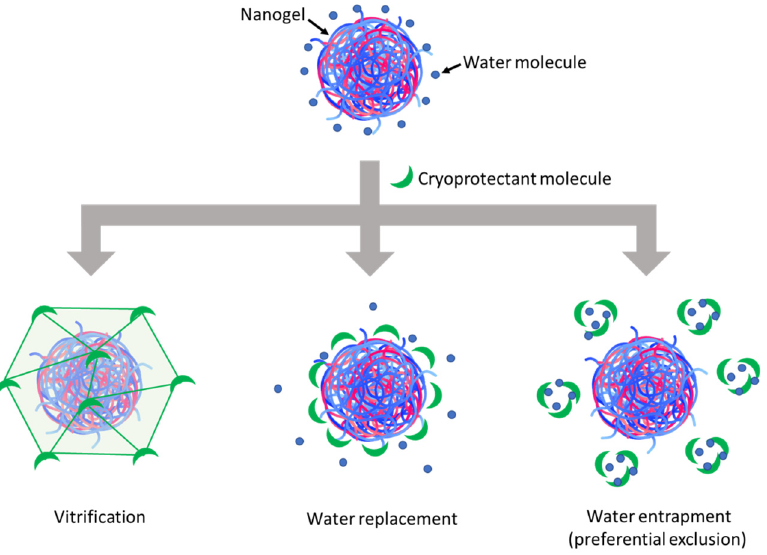
Figure 3. Schematic representation of cryoprotection mechanisms of cryoprotectants.